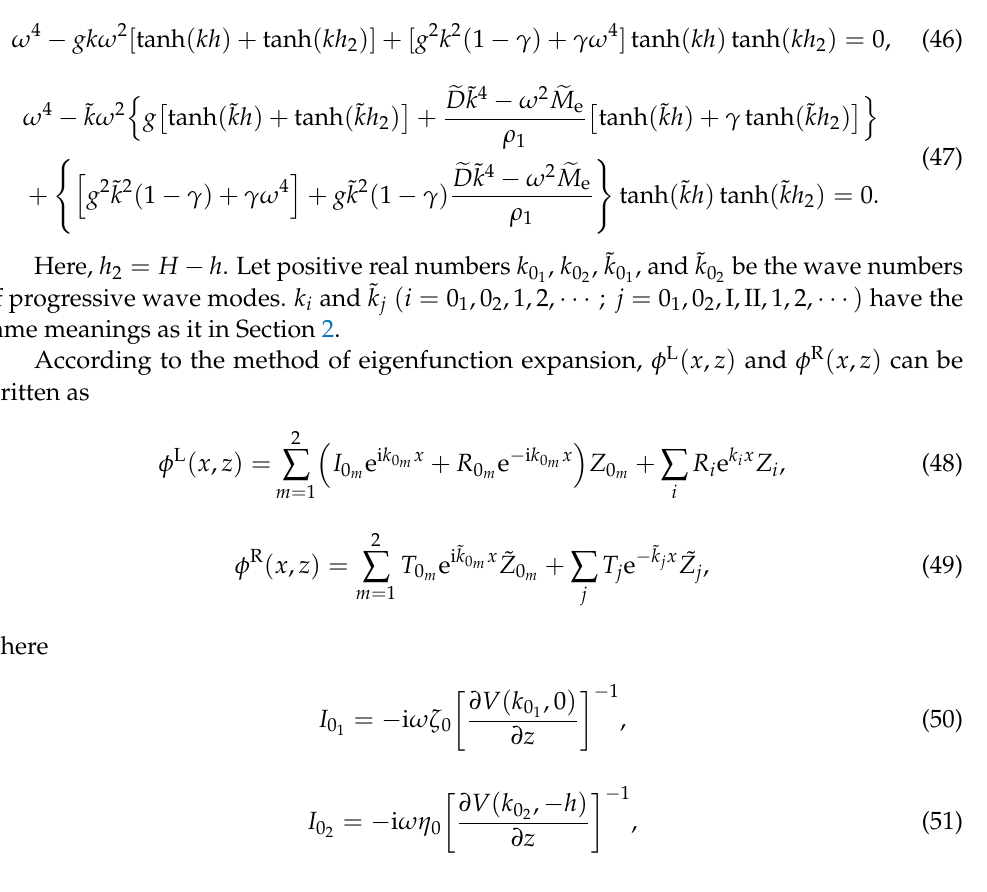
Figure 2. Schematic diagram in a two-layer fluid. The dispersion relations in the open water and the plate-covered regions on the two-layer fluid are presented as